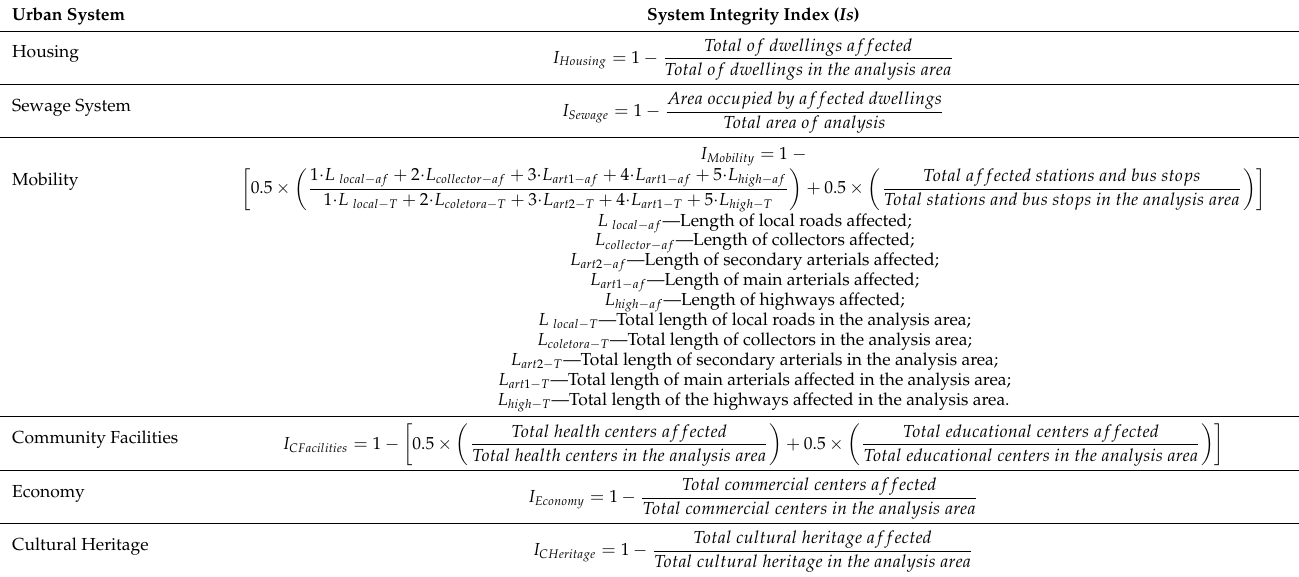
Table 2. Formulation of the System Integrity Index for each urban system considered. System Integrity Index ( Is